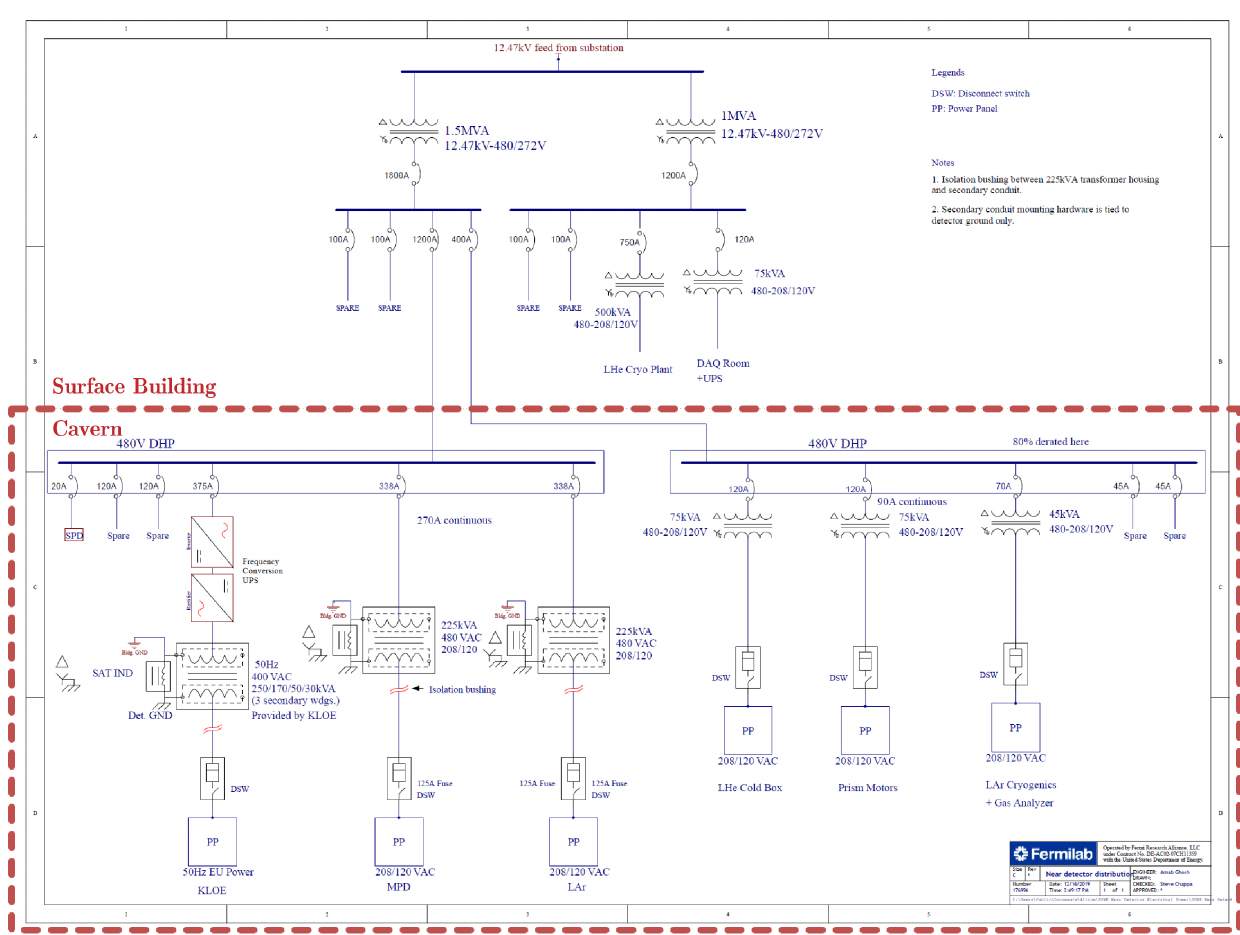
Figure 182. DUNE ND detector power distribution